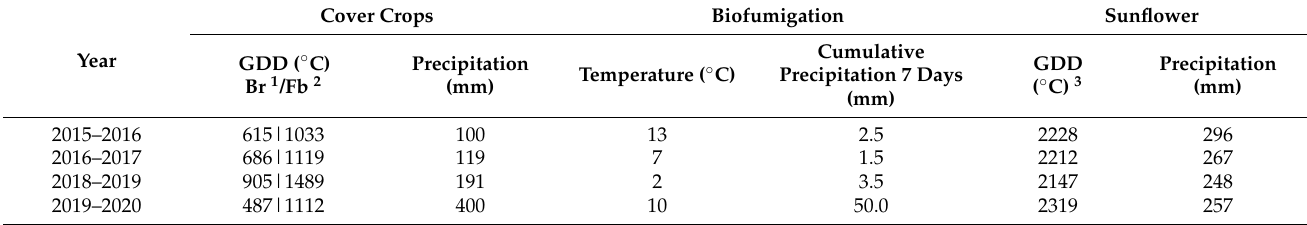
Table 2. Climate conditions of the four-year experiment carried out at Auzeville, France. Cumulative growing degree days and precipitation values are sums of growing season measurements from the sowing date to the date of cover crop destruction, and sunflower harvest. Climate data at biofumigation are the mean day temperature at cover crops destruction and the sum of precipitation 7 days from cover crops destruction. GDD is for growing degree days, Br is for Brassicaceae, and Fb is for